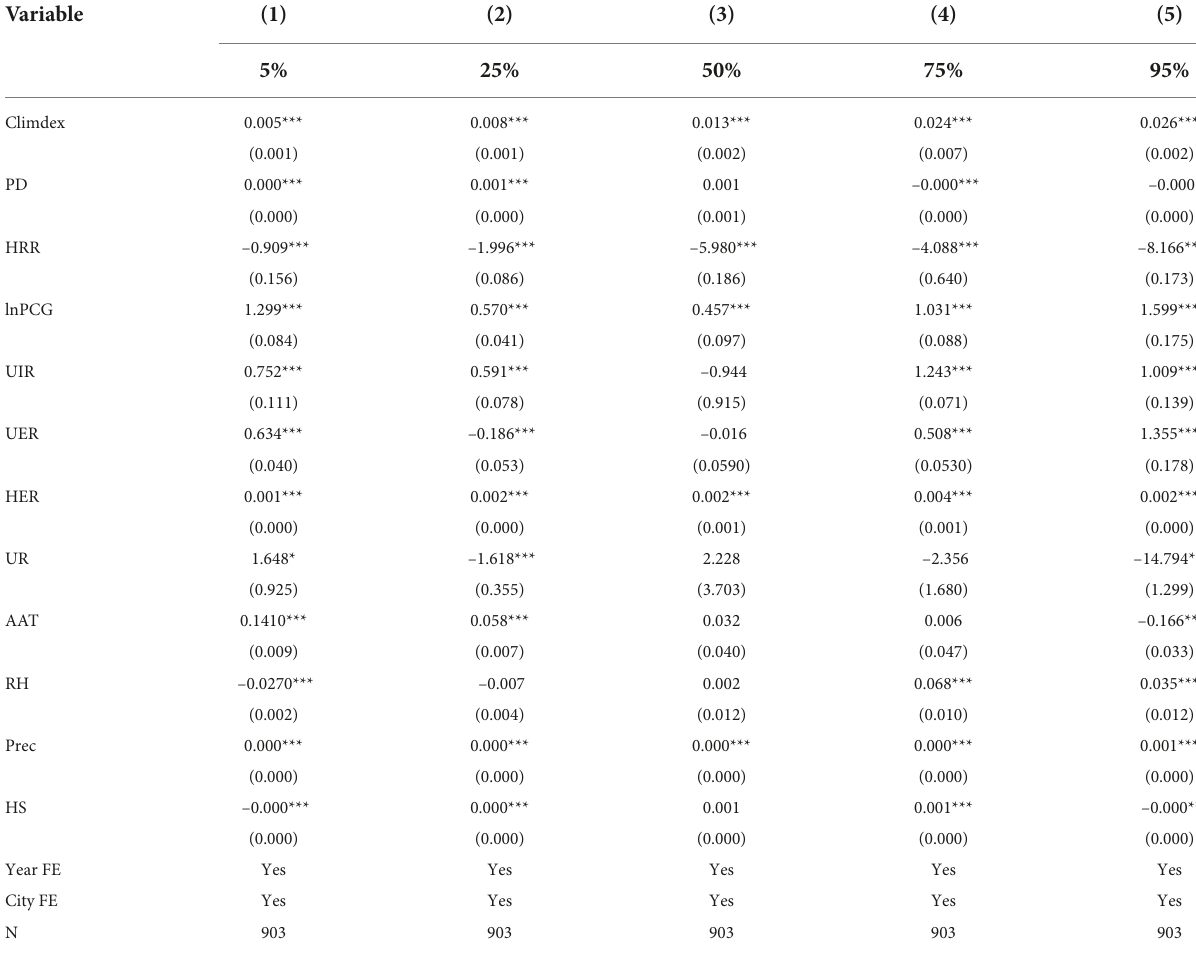
TABLE 4 Quantile regression results of extreme climate on crime rate.